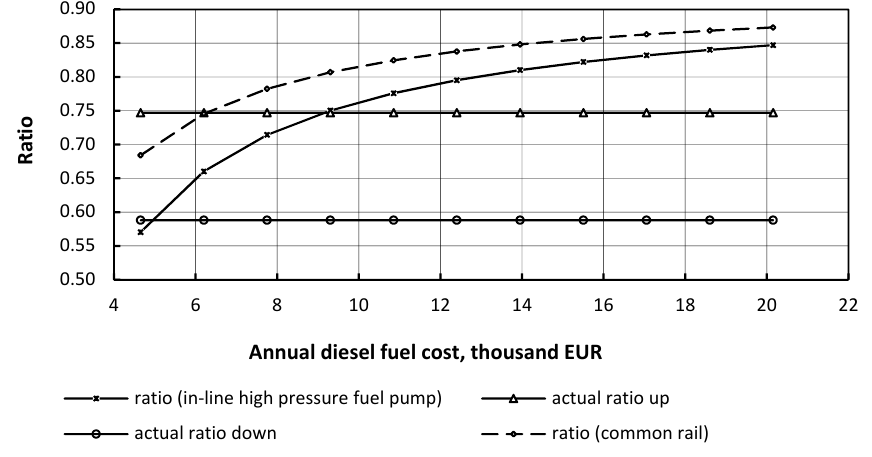
Figure 20. The dependence of the ratio of CNG / diesel fuel prices on the cost of the annual conventional fuel (no CNG fueling station).